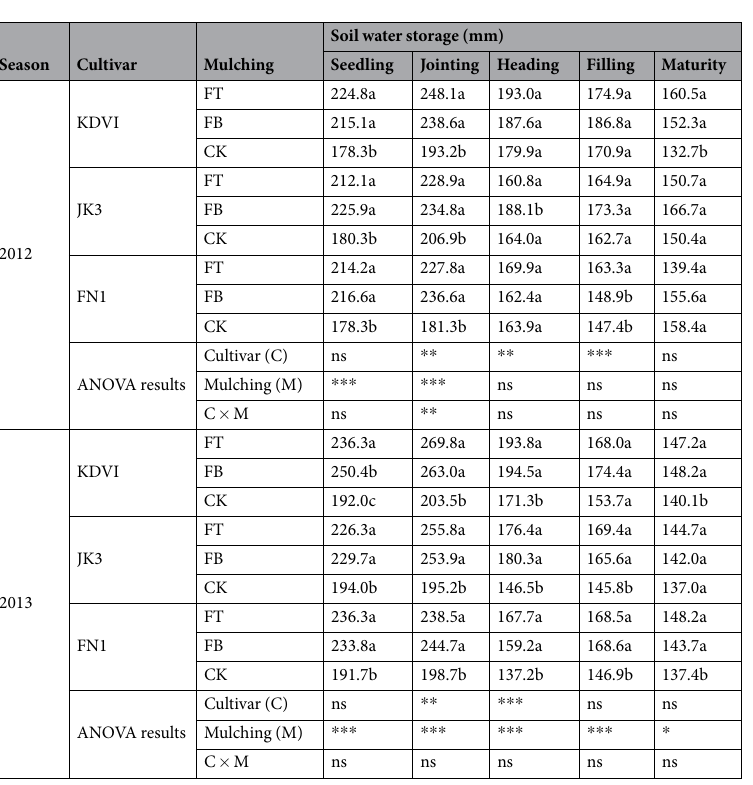
Table 1. Soil water storage (0–120 cm soil layer) as affected by maize cultivars (early- mid- and late-maturing, KDVI, JK3 and FN1, respectively) and ridge-furrow differingin mulching materials (FT, alternative ridge- furrow with transparent film mulching; FB, alternative ridge-furrow with black film mulching and CK, alternative ridge-furrow with no mulching) in both growing seasons, on a sandy clay loam in Kenya, east African Plateau. Values followed by the same letters in each cultivar are not significantly different at p < 0.05 level. * , ** and *** significant at p < 0.05, 0.01 and 0.001 level, respectively; ns, not